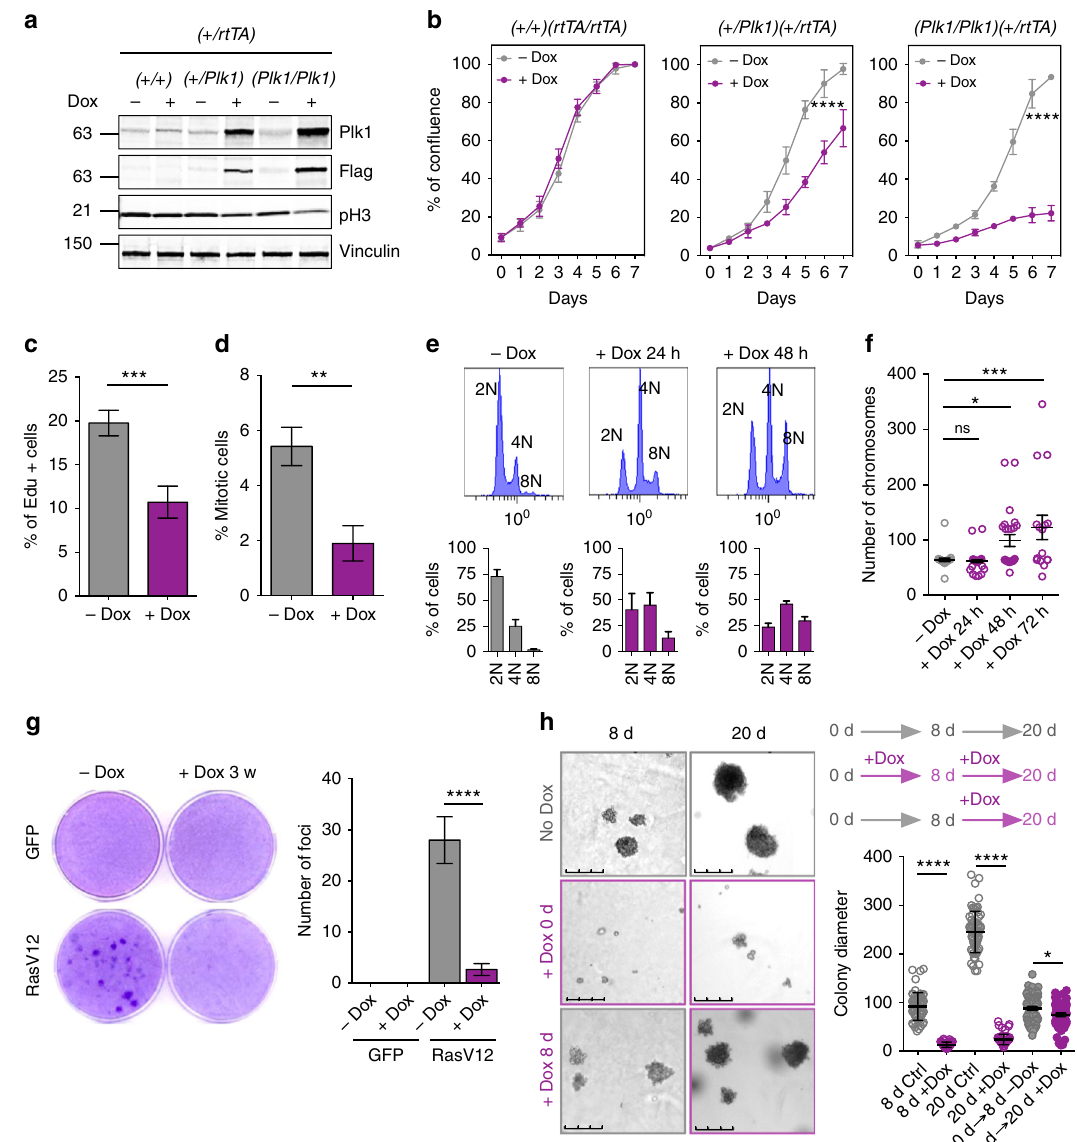
Fig. 2 Plk1 overexpression results in proliferative defects in cultured MEFs. a Expression of Plk1 in MEFs with the indicated genotypes, after 24 h treatment with doxycycline. Cell lysates were immunoblotted with anti-Plk1, anti-Flag, anti-pH3, and anti-vinculin as a loading control. b Quanti fi cation of con fl uence in cultures with the indicated genotypes in the absence ( – Dox) or presence ( + Dox) of doxycycline for 7 days. **** p < 0.0001; two-way ANOVA. c Percentage of EdU-positive cells in ( + /Plk1);(rtTA/rtTA) cultures untreated or treated with Dox for 3 days. Cells were exposed to EdU for 1 h before the analysis. *** p < 0.001; Student ’ s t -test. d Percentage of mitotic cells in ( + /Plk1);(rtTA/rtTA) cultures untreated or treated with Dox for 2 days as detected by phospho-Ser10 Histone H3 immuno fl uorescence. ** p < 0.05; one-way ANOVA. e DNA content in ( + /Plk1);(rtTA/rtTA) cells untreated or treated with Dox for 1 or 2 days. The percentage of 2N, 4N, or 8N cells is indicated in the histograms. f Metaphase spreads of ( + /Plk1);(rtTA/rtTA) cells untreated or treated with Dox for the indicated time. The number of chromosomes per cell is shown in the plot ( n = 25 ( – Dox), n = 41 (24 h), n = 25 (48 h), n = 16 (72 h) cells per condition). ns not signi fi cant; * p < 0.05, *** p < 0.001; one-way ANOVA. g Focus formation assays of ( + /Plk1);(rtTA/rtTA) MEFs transfected with oncogenic HrasV12 or control GFP-expressing vectors in the absence ( – Dox) or presence ( + Dox) of doxycycline. The number of foci is indicated in the histogram. **** p < 0.0001 ( n = 3 replicates); one-way ANOVA. h Soft agar colony formation of immortal Hras transformed MEFs. Colonies are grown in the absence of Dox for 20 days (gray upper panels), or in the presence of Dox since plating (purple mid panels). Additionally, colonies grown in the absence of Dox were supplemented with Dox at day 8 (lower panels). Colony diameter (in microns) is quanti fi ed in the right histogram. Each dot represents one colony (over 50 colonies are quanti fi ed in each set). * p < 0.01; **** p < 0.0001, one-way ANOVA Bonferroni